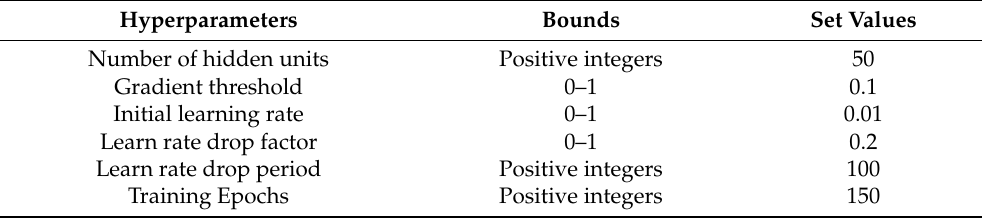
Table 2. Hyperparameters for gated recurrent unit